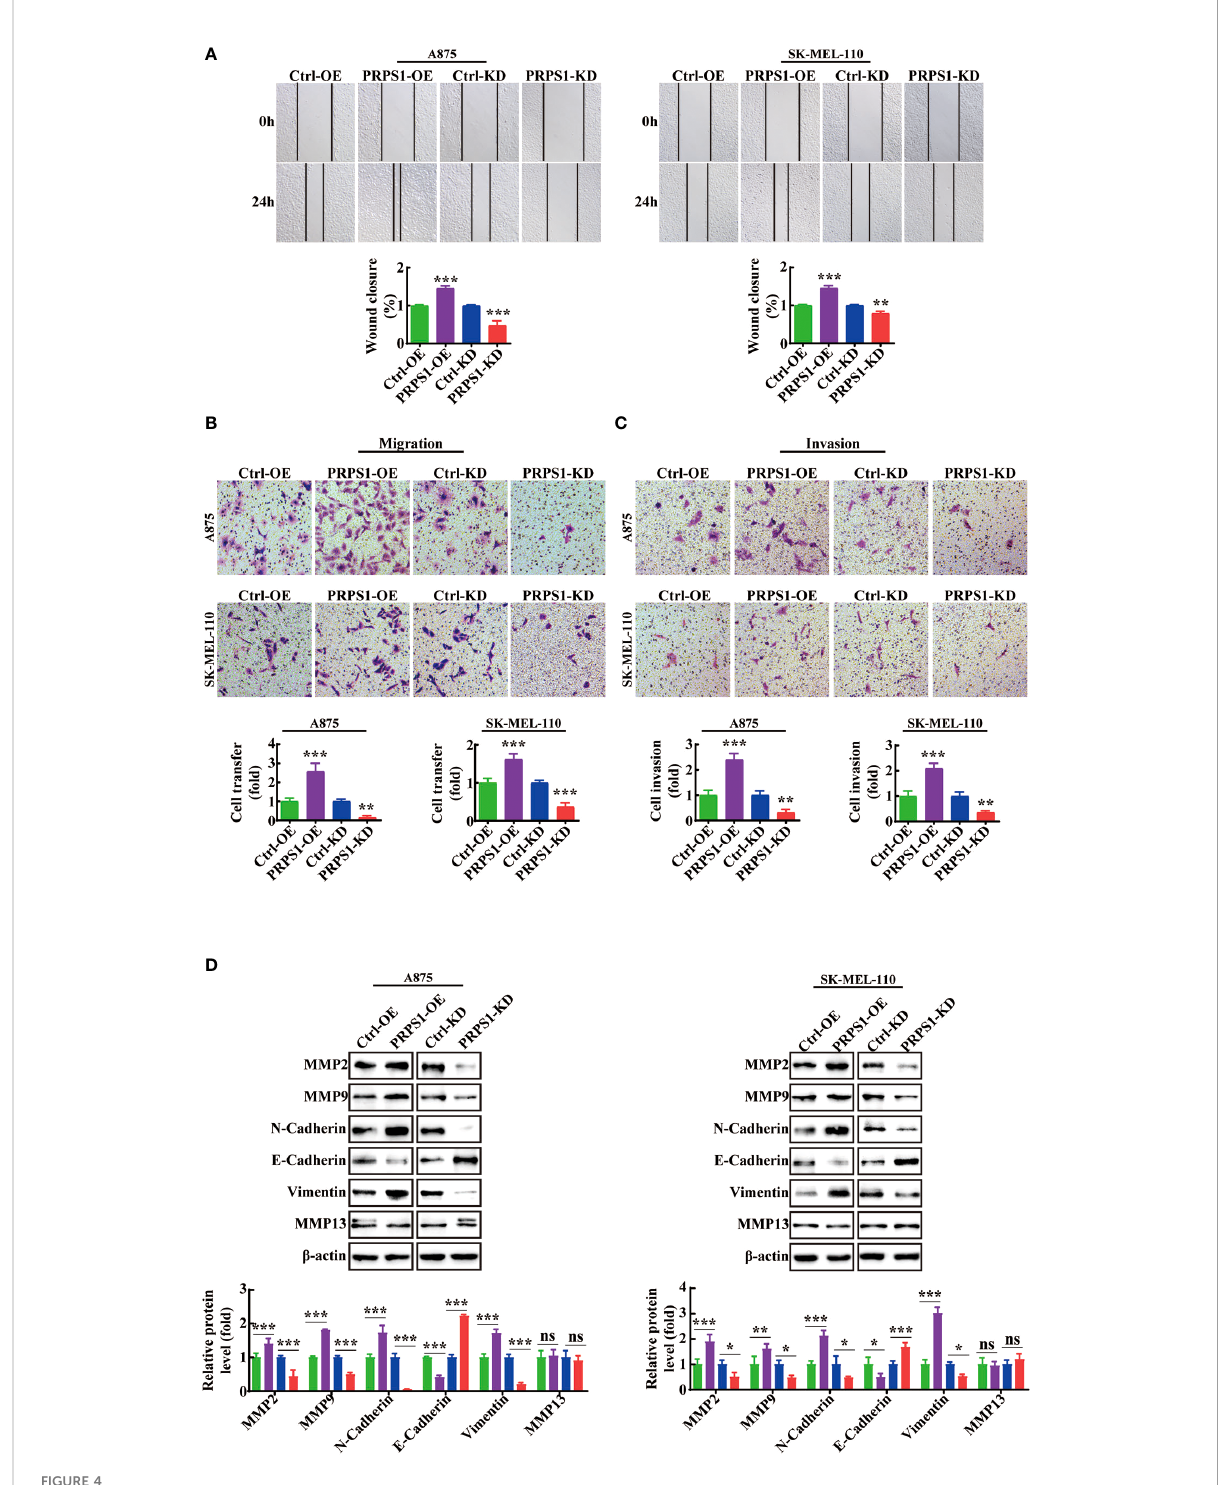
FIGURE 4 PRPS1 advances the migration and invasion of melanoma cells. (A) Representative scratch-wound images and the data analysis of PRPS1 over- expression and knock-down melanoma A875 and SK-MEL-110 cells 0h and 24h after scratch. (B) Representative images of transwell migration of stably transformed melanoma cells after 24h of starvation (top panel). Quanti fi cation of the number of migrating cells per fi eld (bottom panel). (C) Representative images of transwell invasion assay pictured 24h (top panel). Quanti fi cation of the number of invasion cells per fi eld (bottom panel). (D) The expression of EMT-associated proteins in the A875 and SK-MEL-110 melanoma cells with PRPS1 overexpression or knock-down and the control cells. The data represent three independent experiments. (* p <0.05, ** p <0.01, *** p <0.001, ns mean no signi fi cant